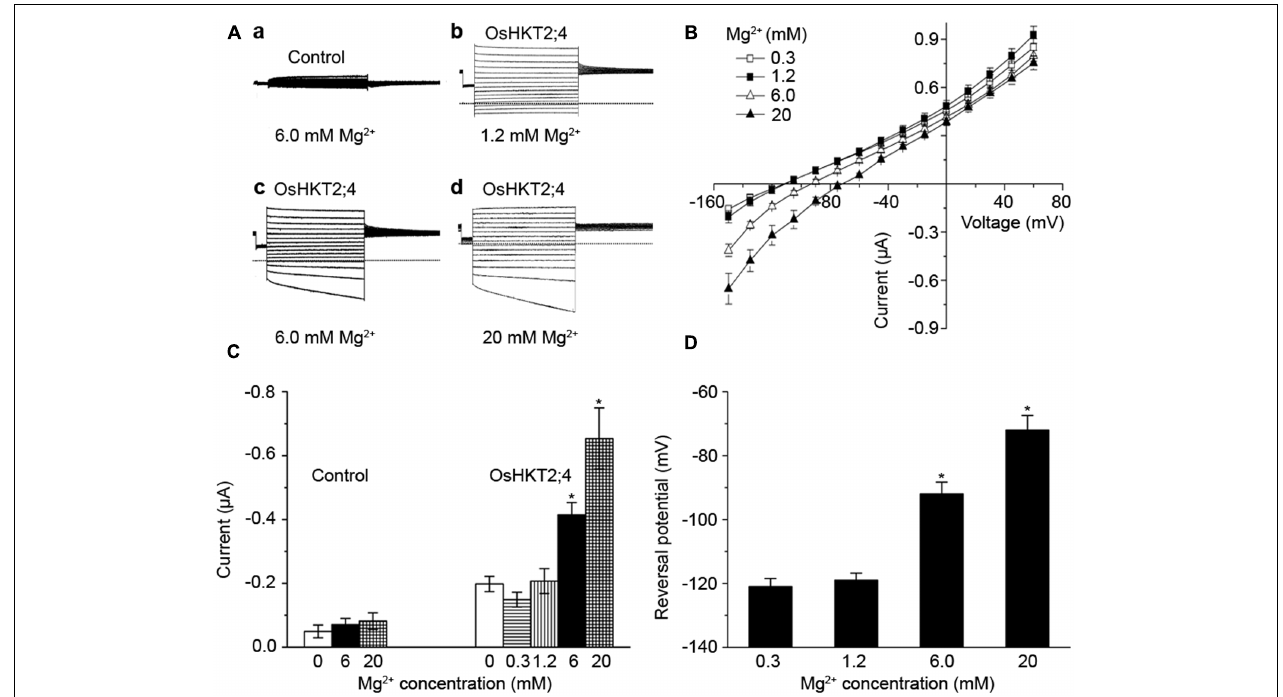
FIGURE 2 | The oocytes expressing OsHKT2;4 produced Mg 2 + currents under the high-Mg 2 + conditions. (A) The typical current traces generated from the oocytes injected with water perfused with (a) 6 mM Mg 2 + (Control) and from the oocytes expressing OsHKT2;4 (OsHKT2;4) perfused with (b) 1.2 mM, (c) 6 mM or (d) 20 mM Mg 2 + . Dotted lines represent the zero current level. (B) The current-voltage relationships deduced from the oocytes expressing OsHKT2;4 perfused with 0.3, 1.2, 6 or 20 mM Mg 2 + . Summarized current data are from 8 cells/condition. (C) The current amplitudes at –150 mV recorded from the oocytes injected with water (Control) and oocytes expressing OsHKT2;4 (OsHKT2;4) perfused with different Mg 2 + concentrations. (D) Reversal potentials of currents generated from the oocytes expressing OsHKT2;4 in the presence of various concentrations of Mg 2 + as indicated in the figure. Data in Figure 2 are presented as representative recordings or as mean ± SE of n ( n = 6) observations with three repetitions, in which n is the number of samples. Asterisks indicate statistically significant differences compared with data from oocytes expressing OsHKT2;4 perfused with 1.2 mM Mg 2 + (Unpaired student’s t -test, ∗ P <